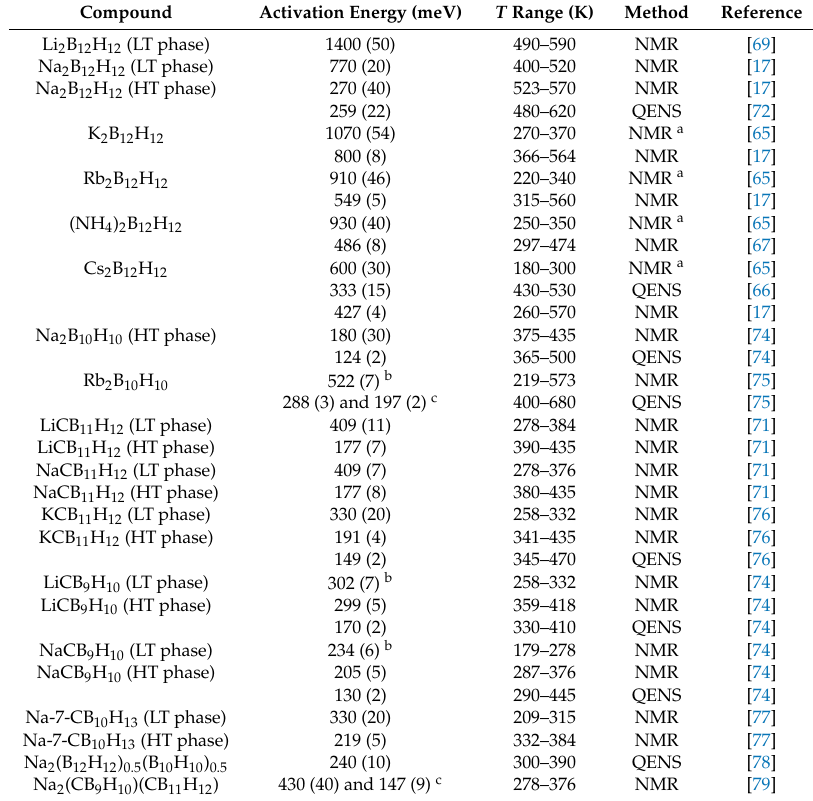
a From 11 B line width measurements; b average values for activation energy distributions; c for the slow and fast jump processes,